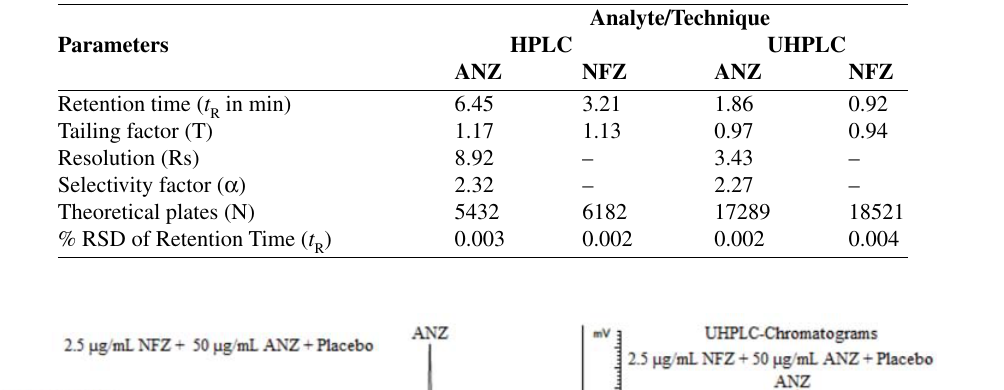
Table 2. System suitability test parameters